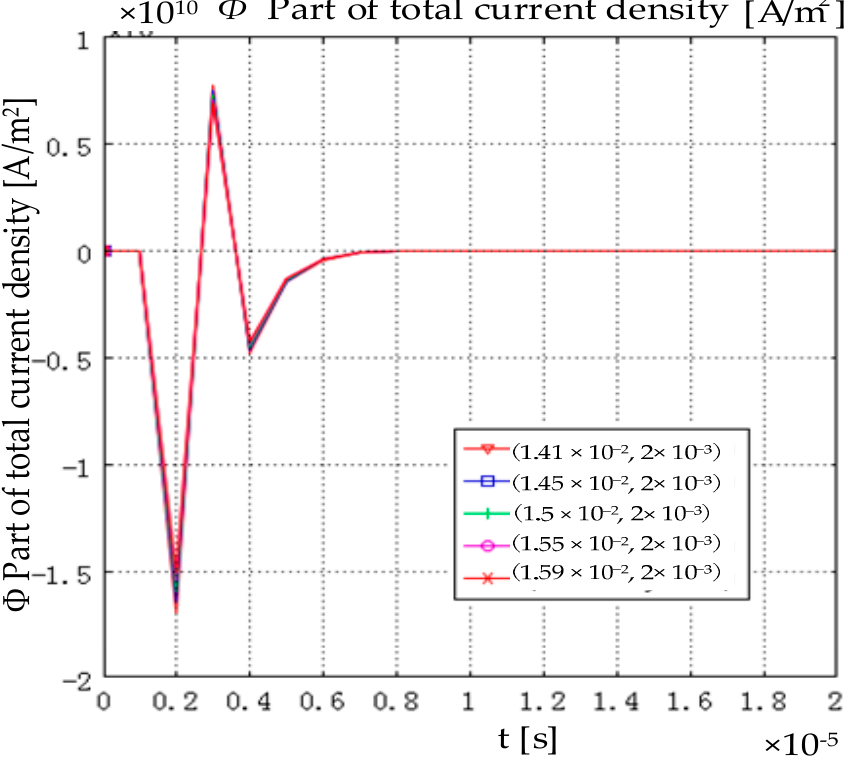
Figure 3. Part of the total current density at each point in the model .